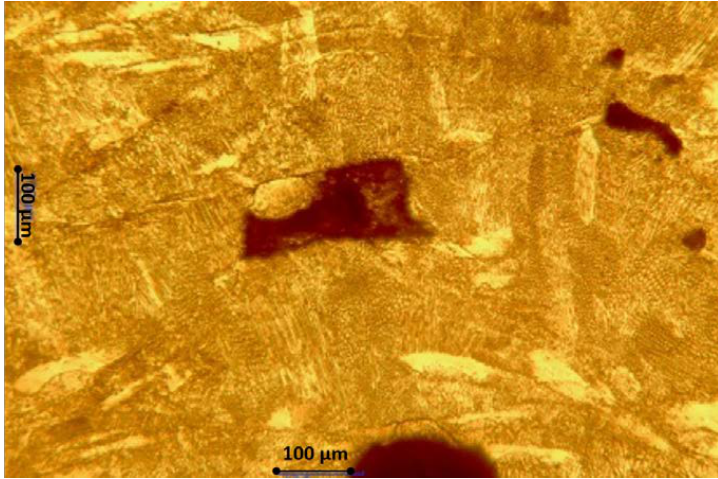
Figure 9. Multilayered build #81 (High P f :T s ) large porosity due to the lack of energy available from increased travel speed, Vickers: 221 ± 11. Table 3. Measured parameters of multilayered sample builds.